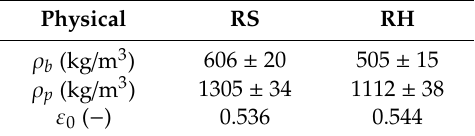
Table 6. Averaged density and porosity of RS and RH pellets.